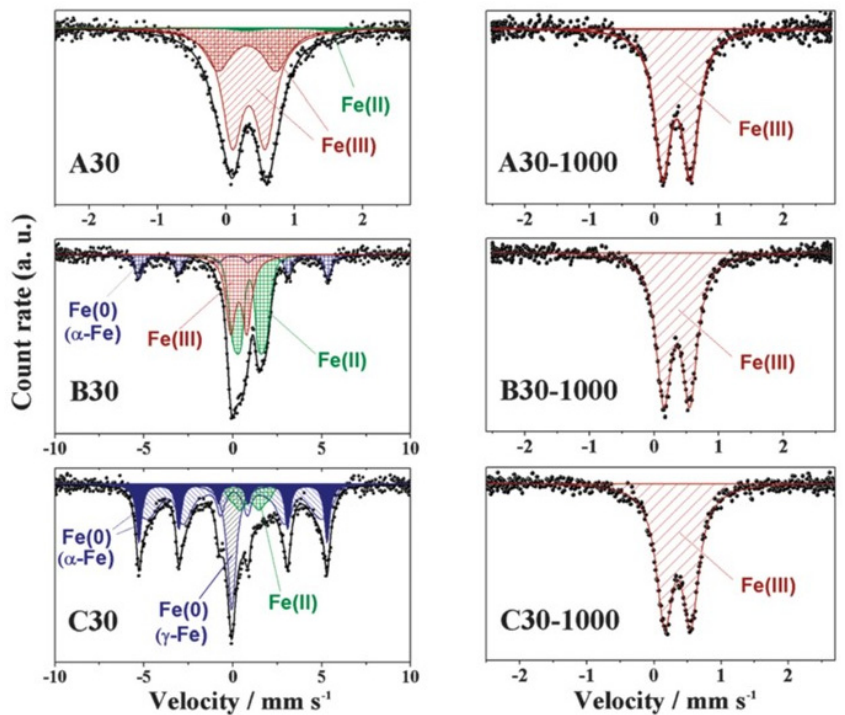
Figure 10. Mössbauer spectra of the samples of ZnO milled for 30 h in a chromium-rich stainless- steel bowl with stainless stell balls before ( left ) and after calcination at 1000 °C ( right ). Conditions: (A) exposed to air, with atmosphere refreshed every hour, (B) sealed under air, and (C) sealed under nitrogen [172] .